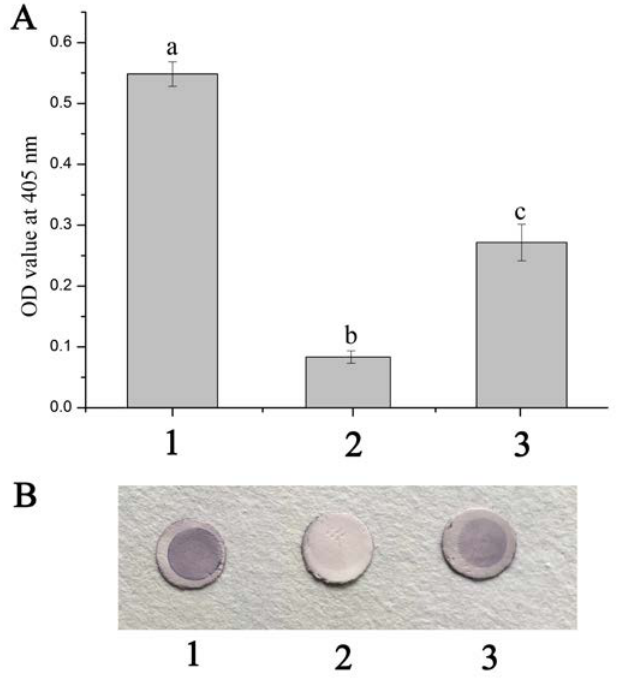
Figure 2. Detection of the blocking effects of anti-rFcβInt-ER antibodies by ELISA ( A ) and dot-blot ( B ). 1: HmFc incubated with WSSV-DIG as positive control; 2: HmFc pre-incubated with anti-rFcβInt-ER antibodies was then incubated with WSSV-DIG; 3: PBS instead of WSSV-DIG as negative control. Different letters on the bar represent the statistical significance ( p < 0.05) compared to the other groups.